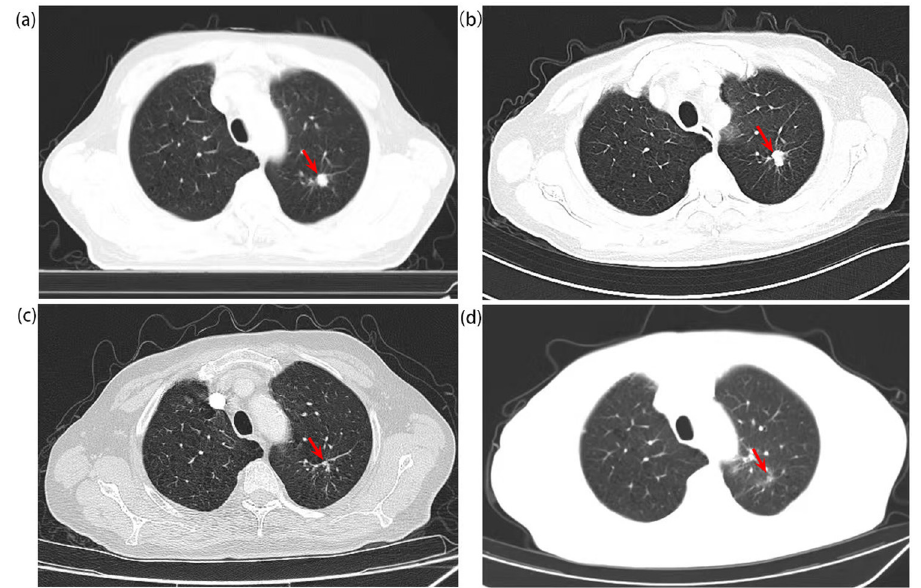
Figure 2: The CT scan of the chest shows the lung carcinoma: ( a ) shows a nodular hyperdense shadow seen in the posterior segment of the left upper lobe of the lung with medium contrast in August 2020 ( with a size about 11 mm × 12 mm ) . ( b ) Shows the lesion before chemotherapy plus immunotherapy against PD - 1. ( c ) Shows that the lesion was signi fi cantly reduced after two cycles of chemotherapy plus immunotherapy against PD - 1. ( d ) Shows that the lesion almost disappeared after radiotherapy.